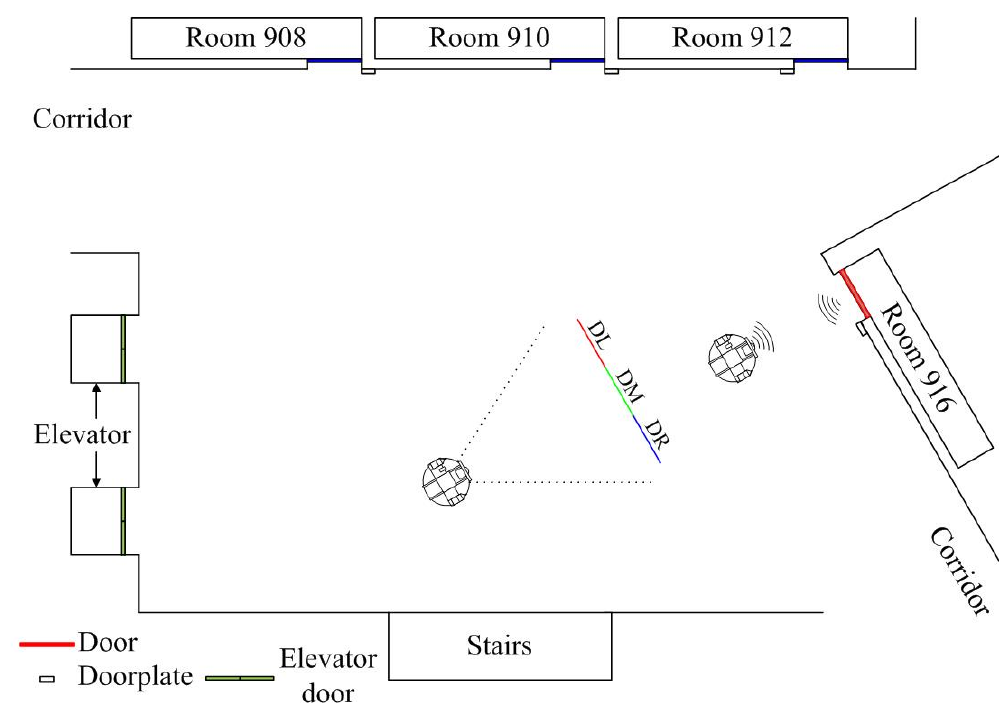
Figure 20. Tag posted on the door.